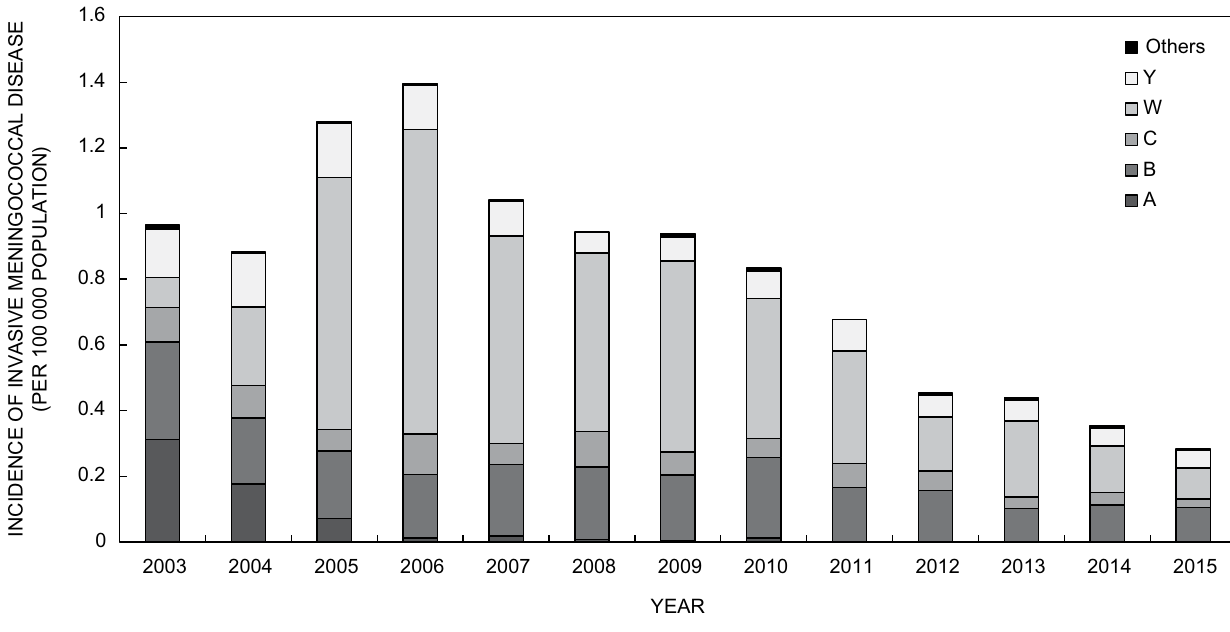
Figure 1: Incidence of invasive meningococcal disease by serogroup, South Africa, 2003-2015 ( n =